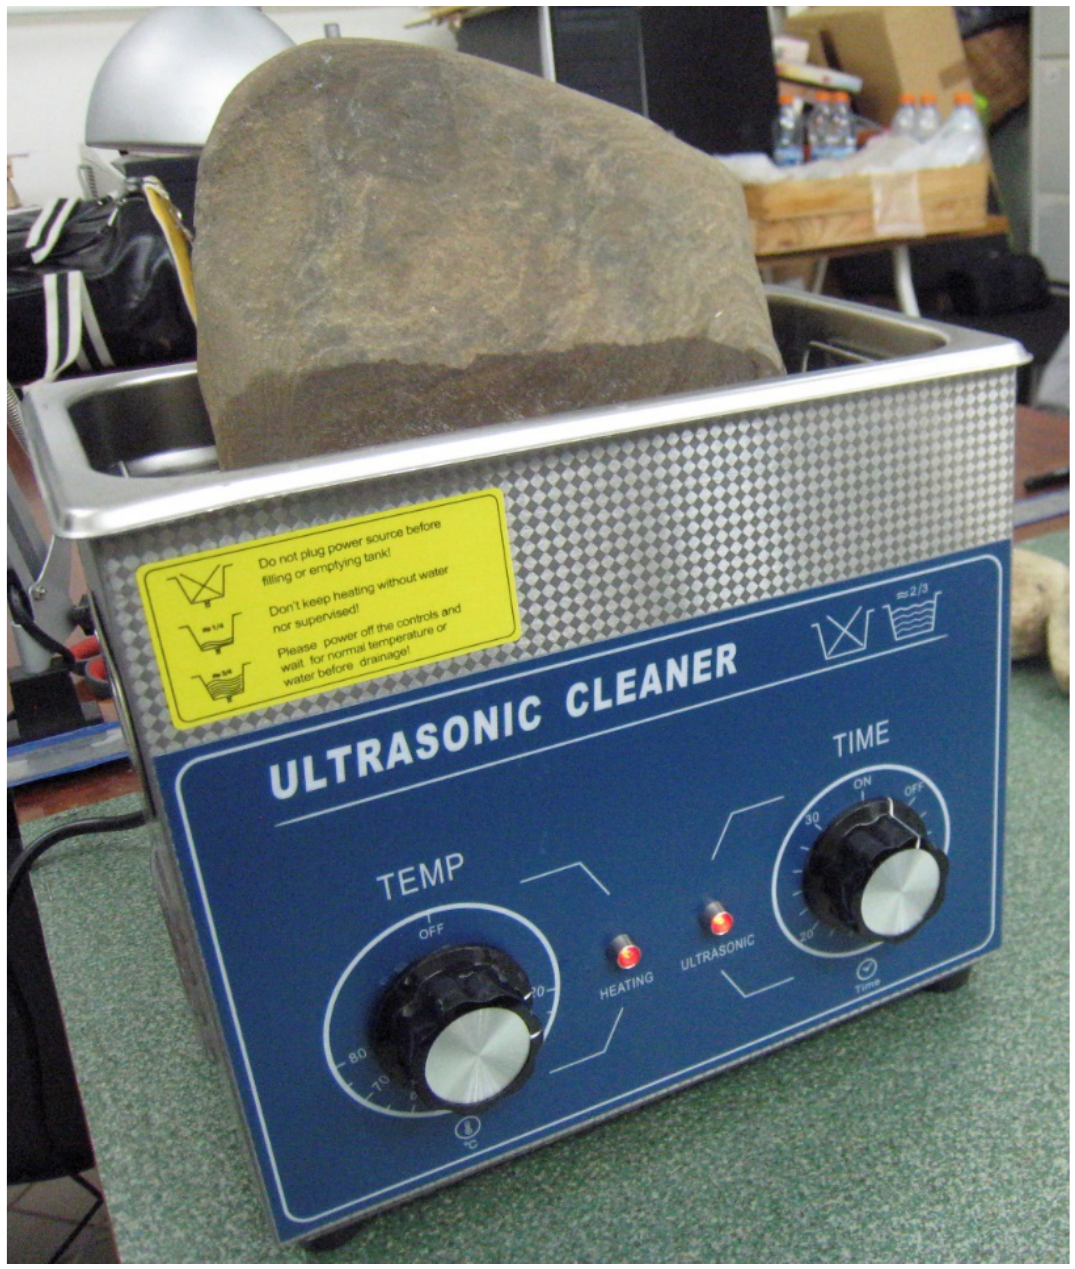
Figure 4. Solubilization of the adhering biogenic residues from a slab found on the Kamennaya Balka II site using an ultrasonic